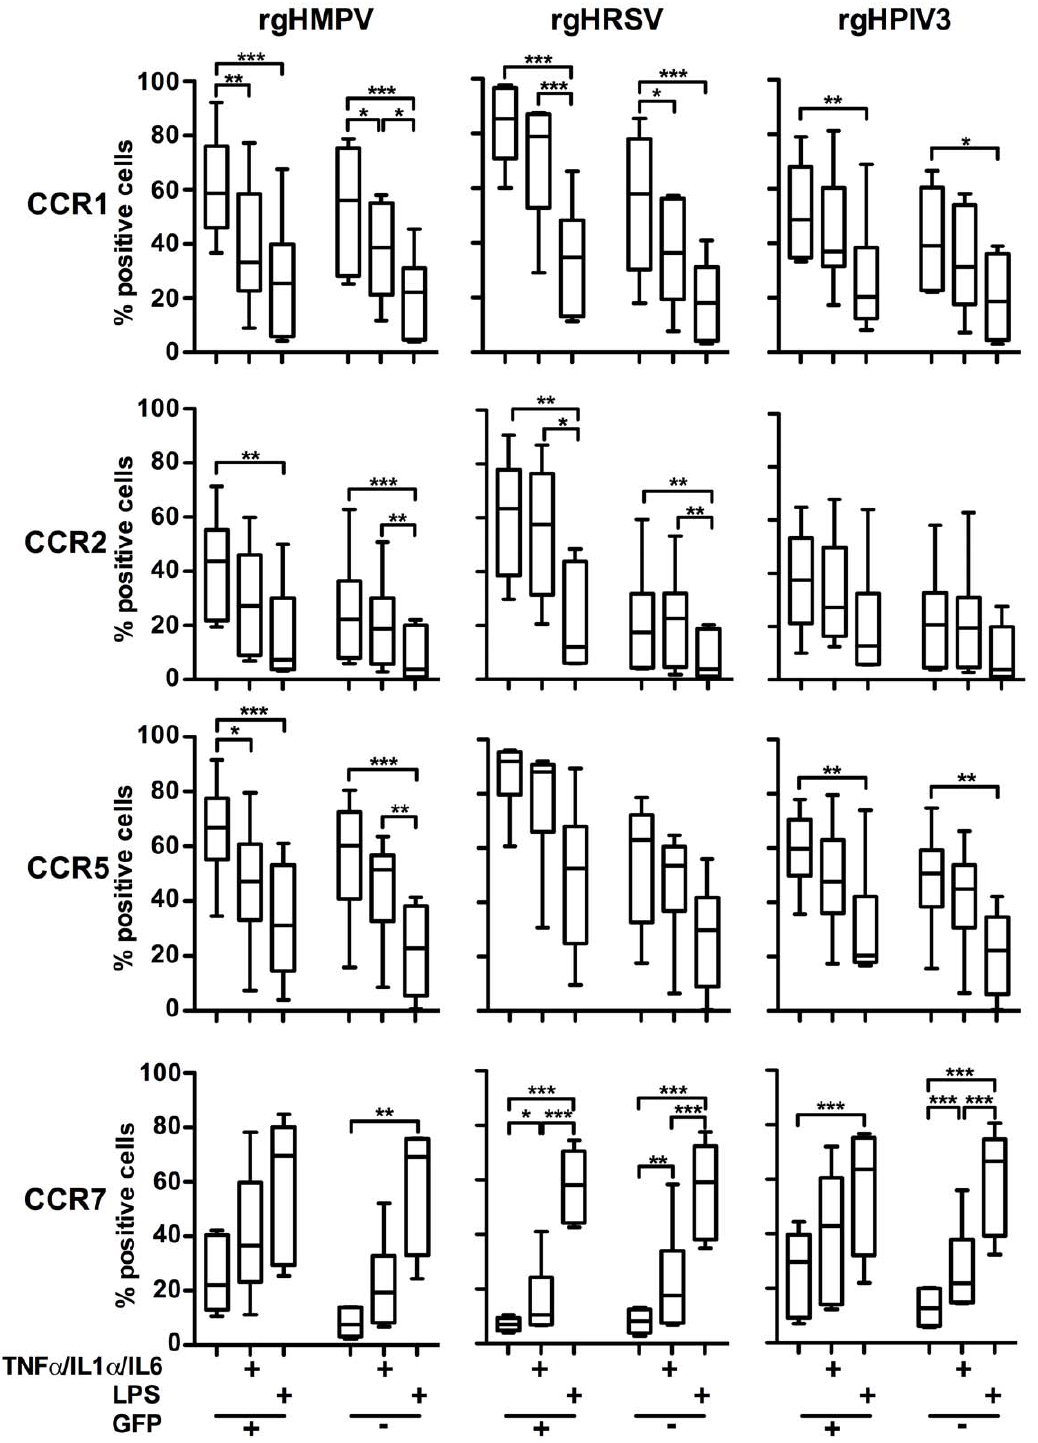
Figure 6. Surface expression of chemokine receptors on GFP-positive and GFP-negative MDDC after inoculation with rgHMPV, rgHRSV and rgHPIV3 and secondary stimulation with the pro-inflammatory cytokines TNF- a /IL-1 a /IL-6 or with LPS. 4–6 h after infection of immature MDDC with rgHMPV or rgHRSV, cells were stimulated with a cocktail of the pro-inflammatory cytokines TNF- a /IL-1 a /IL-6 or LPS. 48 h after the initial infection, GFP-positive and GFP-negative cells were analyzed by flow cytometry for cell surface expression of the indicated chemokine receptors. n=6 donors. ( + ) GFP + population, ( 2 ) GFP 2 population. The box plots show the median (horizontal line), flanked by the 2 nd and 3 rd quartile. The outers bars show the range of values. Statistical differences between relevant groups, i.e. with and without cytokine treatment, are indicated by asterisks (* p # 0.05, **p # 0.01, *** P # 0.001, see materials and methods).